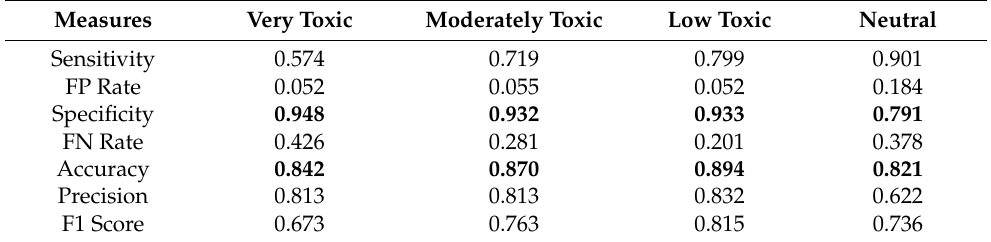
Table 9. Effectivity of Bagging method for recognition of four degrees of toxicity in online